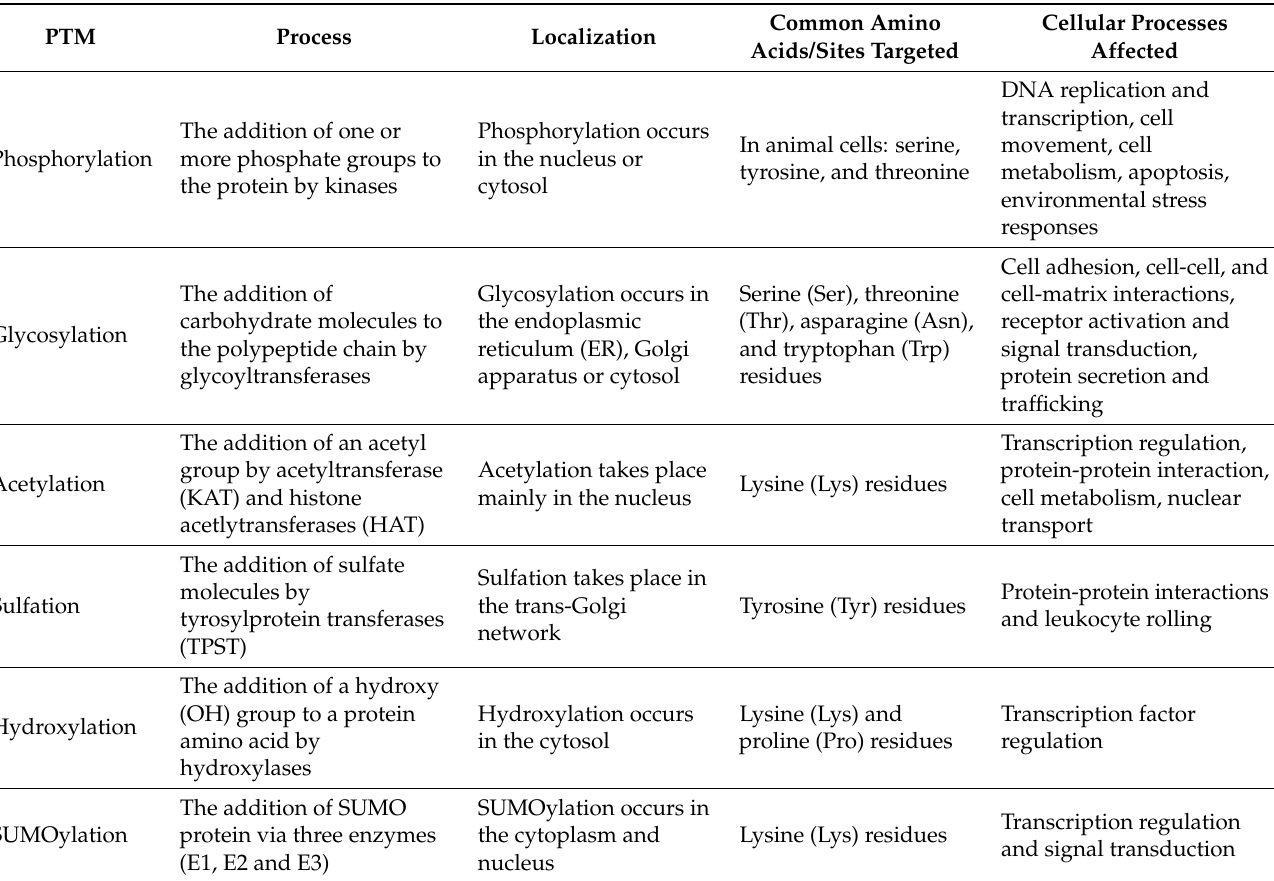
Table 1. The main types of PTMs: process, localization, targeted sites, and affected biological